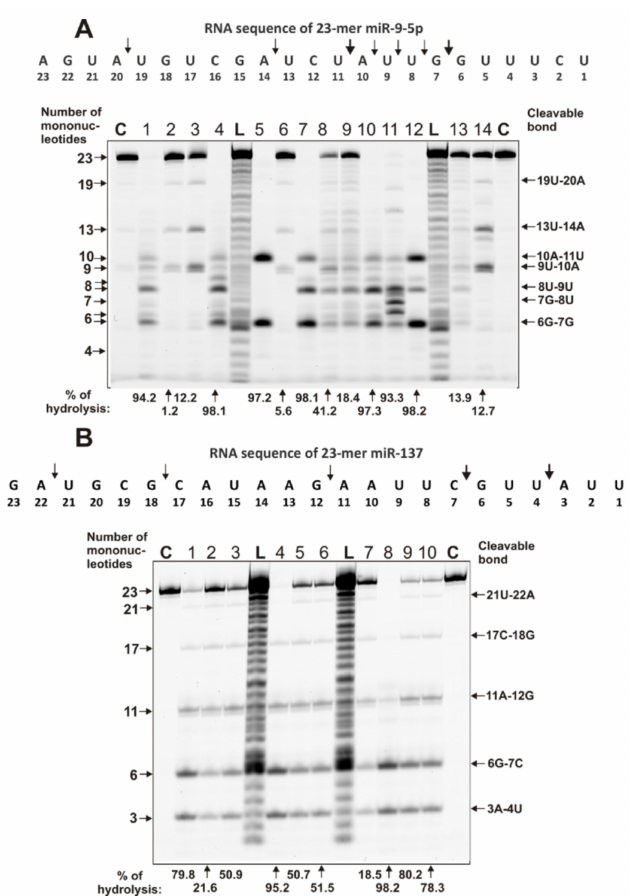
Figure 4. The patterns of cleavage of oligonucleotides Flu-miR-9-5p ( A ) and Flu- miR-137 ( B ) by different preparations of 0.6 µ M IgGs for 1 h of incubation from sera of 10–14 different MS patients. The products of hydrolysis were detected due to the fluorescent residue (Flu) on the 5’-ends of the miRNAs. Lane C corresponds to ONs incubated in the absence of Abs, while Lane L corresponds to the length of ONs. The numbers of IgG preparations, lengths of the products, and the percentage of microRNA cleavage by each preparation of IgG are indicated in panels ( A , B